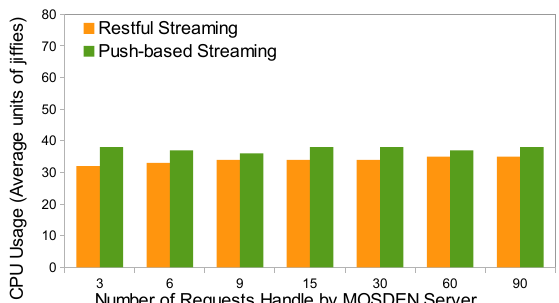
Figure 12. Comparison of CPU Usage by MOSDEN Server